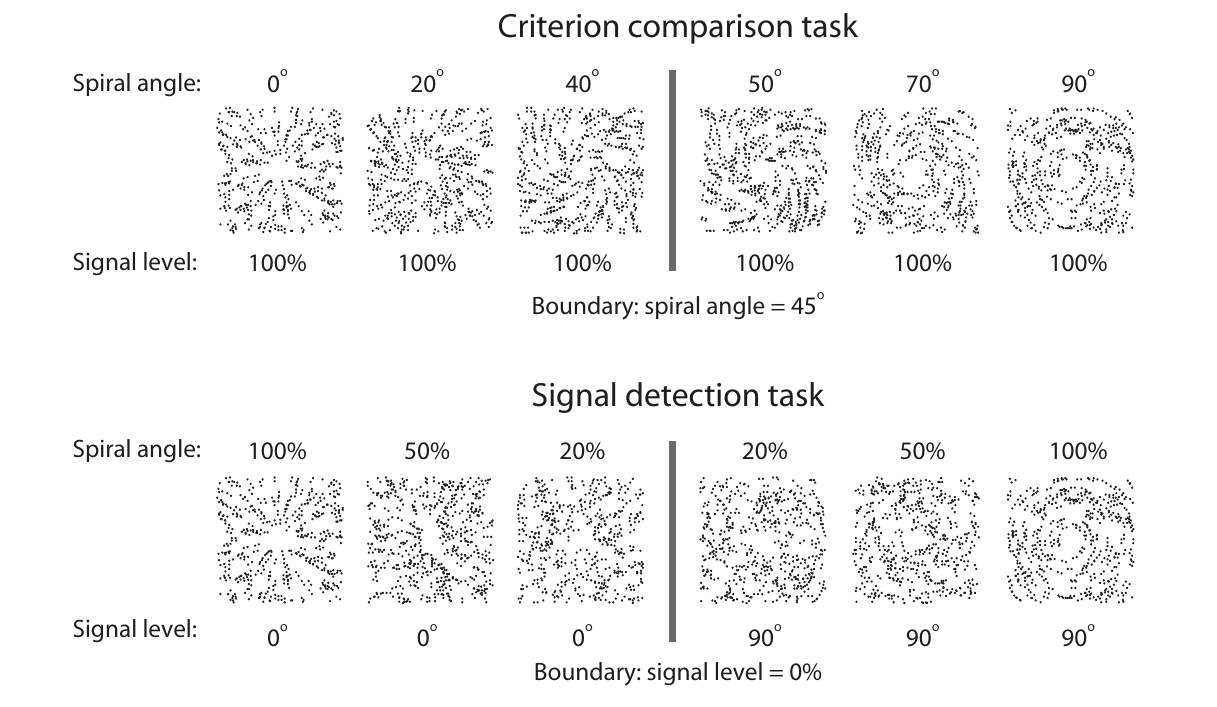
FIGURE 1 | Stimulus sets for the criterion comparison and signal detection tasks. For the criterion comparison task, the signal level of the stimuli was set to 100%, and the spiral angles varied from 0 ◦ to